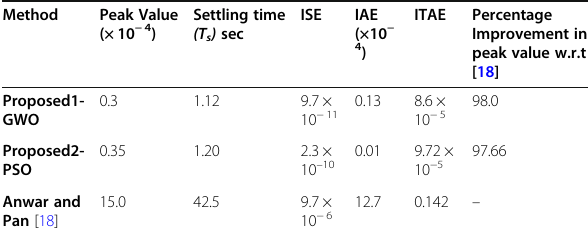
Table 3 Comparison analysis for case study 3